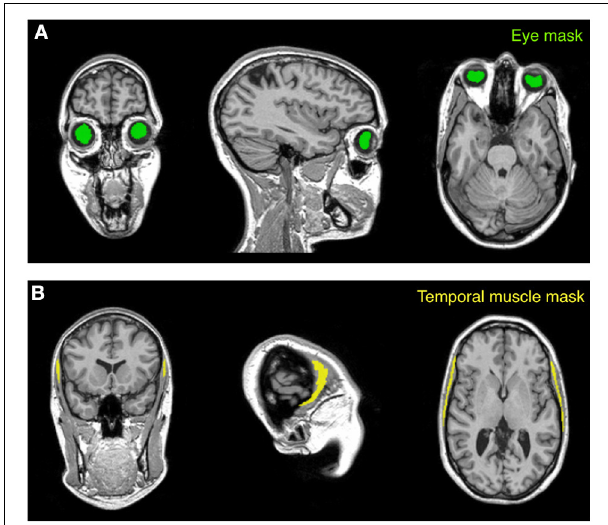
FIGURE 3 | Masks used for the calibration procedure. The calibration algorithm is based on values extracted from two anatomical masks (eye and temporal muscle) warped to the subject space. The eye mask (A) is located within the vitreous humor of the eyeball and encloses the gel that fills the space between the retina and the crystalline lens. The temporal muscle mask (B) , which is one of the main muscles involved in the mastication process, is set on the bulk of the temporalis muscle that covers the temporal bone. The subject represented in the figure is Subject 30 of the KIRBY21 database, as in Figure 1 .